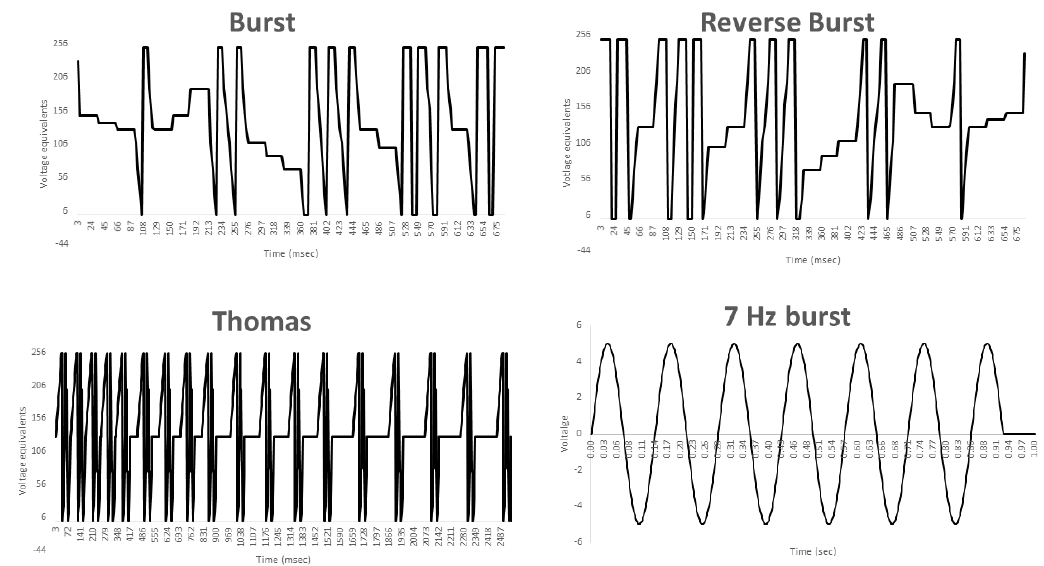
Figure A3. Graphical representation of the burst-firing EMF pattern.